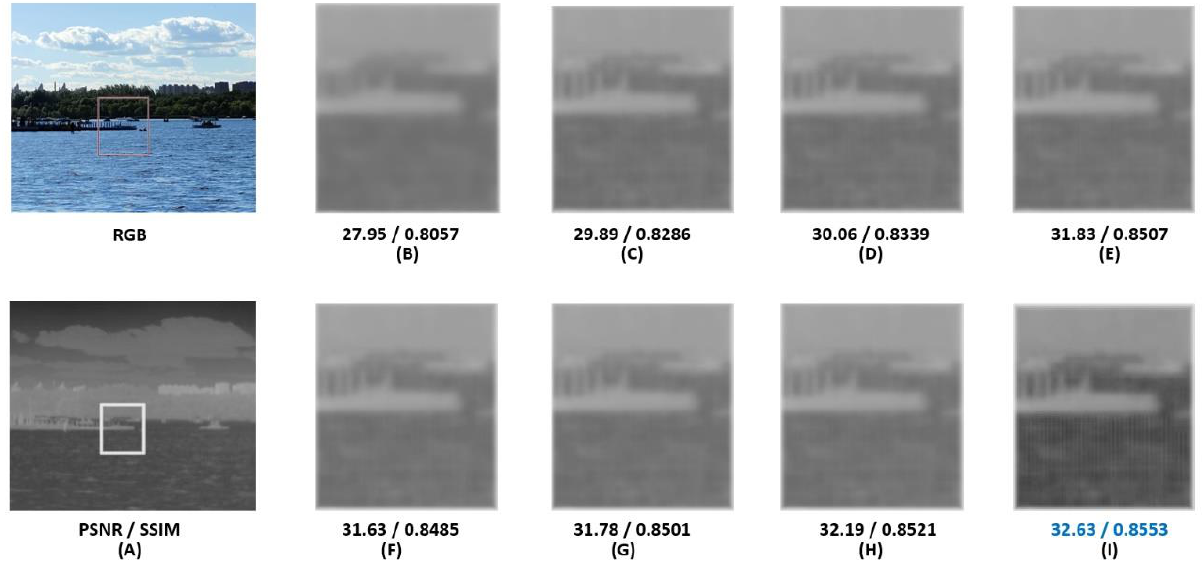
Figure 13. Comparison of restored results on bay by different super-resolution methods (×4). ( A ) HR ( B ) Bicubic ( C ) SRCNN ( D ) FSRCNN ( E ) VDSR ( F ) DRCN ( G ) LapSRN ( H ) RCAN ( I ) Ours.